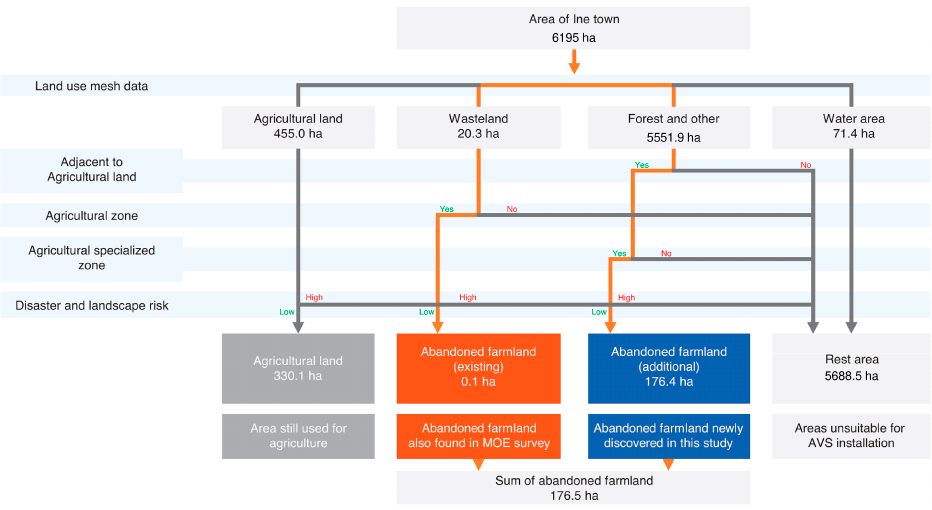
Figure 4. Flowchart of land use classification.